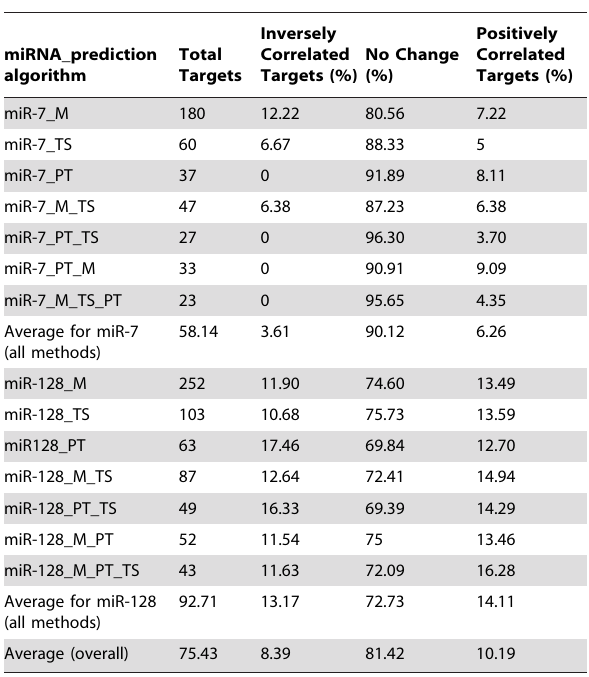
Table 6. Summary values of IC, PC and NC mRNAs in CEPI vs. OSE for miR-7 and miR-128 using ‘‘experimentally validated’’ targets